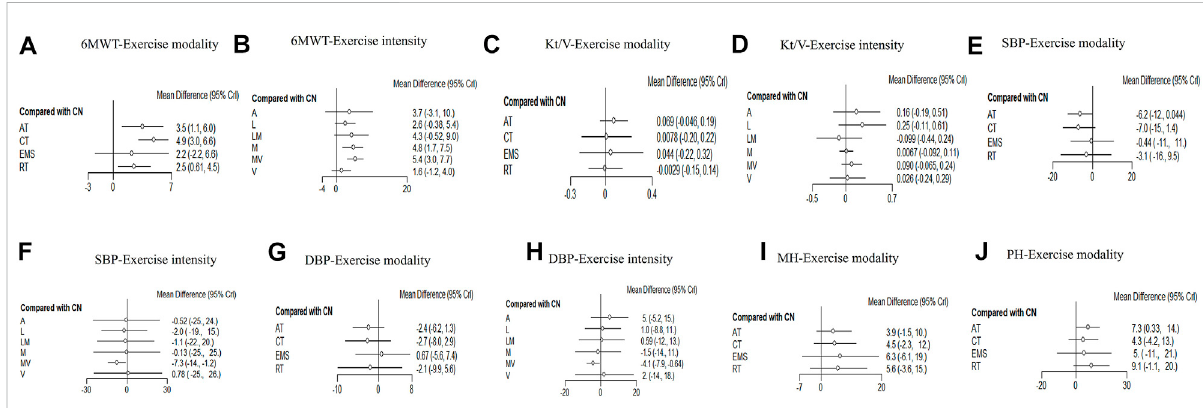
FIGURE 3 Forest plots for each outcome category represent the comparisons of the active intervention with no intervention (control group). (A) : 6MWT- exercise modalities and (B) : 6MWT-exercise intensities. (C) Kt/V-exercise modalities. (D) : Kt/V-exercise intensities. (E) Systolic blood pressure- exercisemodalities. (F) :Systolicbloodpressure-exerciseintensities. (G) :Diastolicblood pressure-exercisemodalities. (H) :Diastolic bloodpressure- exercise intensities. (I) Mental health-exercise modalities. (J) Physical health-exercise modalities.